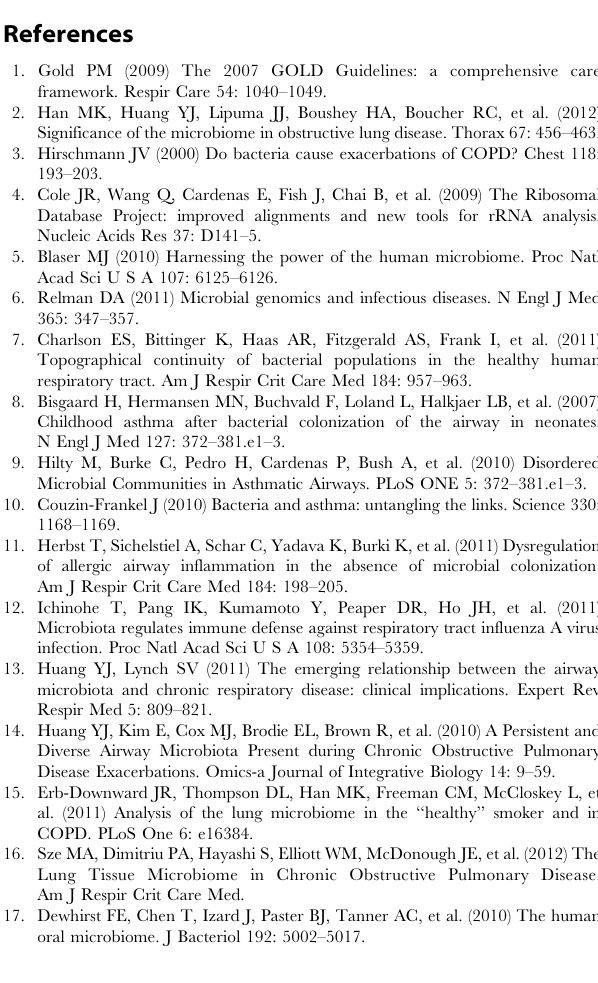
curve, samples from patients with Severe COPD are indicated with thicker curves. Figure S2 Venn Diagram Analysis Demonstrates Signif- icant Overlap Between Moderate and Severe COPD Sample Operational Taxonomic Units (OTU). A Venn diagram was created using mothur at an OTU similarity cutoff of 97%. All 10 control samples, 14 Moderate COPD samples, and 8 Severe COPD samples were merged into 3 groups–Control (pink), Moderate COPD (green) and Severe COPD (purple). The Control, Moderate COPD, and Severe COPD groups contained 202, 245, and 99 unique OTUs, respectively. Forty-six OTUs were found in all three groups. The largest number (96) of OTUs shared between two groups were shared by the Moderate and Severe COPD groups. In contrast, the Control group shared only 25 and 12 OTUs with the Moderate COPD and Severe COPD groups, respectively. Figure S3 Principal Coordinate Analysis Demonstrates No Clustering Based on Percent Emphysema, Age, Gender, or Theophylline Use. Principal Coordinate Analysis was performed using mothur and Fast UniFrac, and the results for principal coordinates 1 and 2 are shown. A. Percent Emphysema. Percent of lung involved by emphysema was calculated from FORTE study entry chest CT scans. Patients were divided into Low ( , 25%, yellow), Medium (25–40%, green) and High ( . 40%, blue) percent emphysema tertiles. Samples do not cluster based